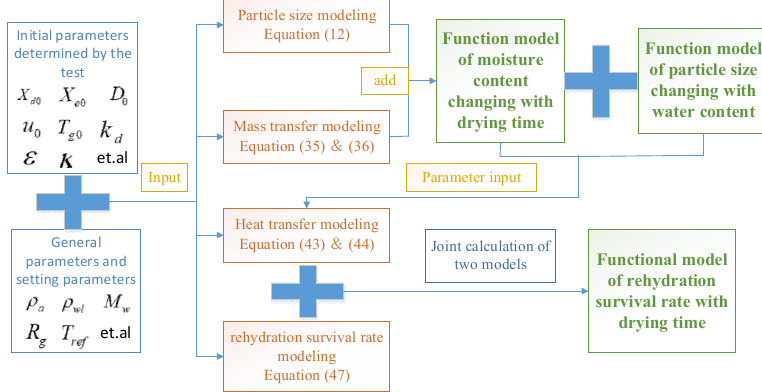
Figure 13. Liquor yeast diagram of mathematical model operation logic.